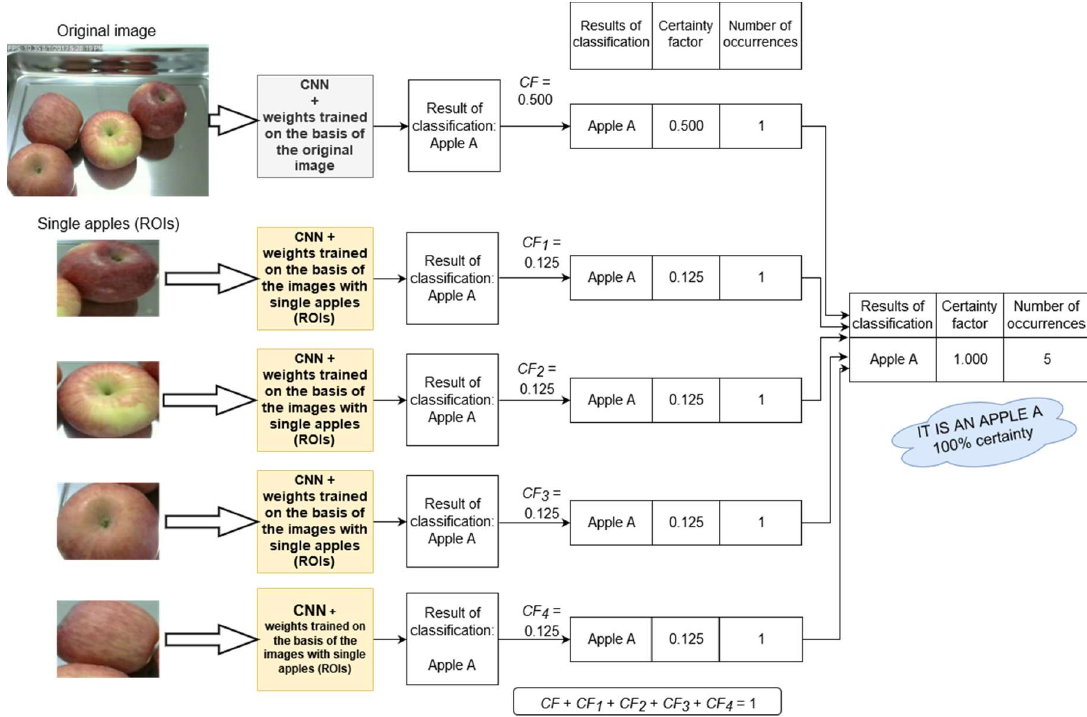
Figure 3. An example of classification using the proposed method: unambiguous classification (based on the original image and ROI images).